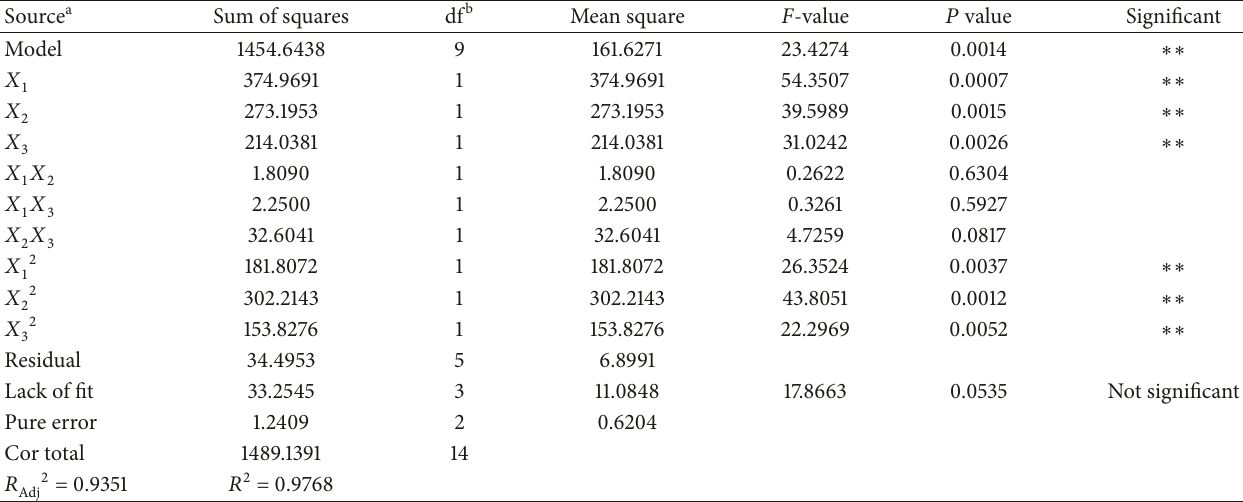
Table 4: Estimated regression coefficients for quadratic polynomial model and ANOVA for the experimental results. Source